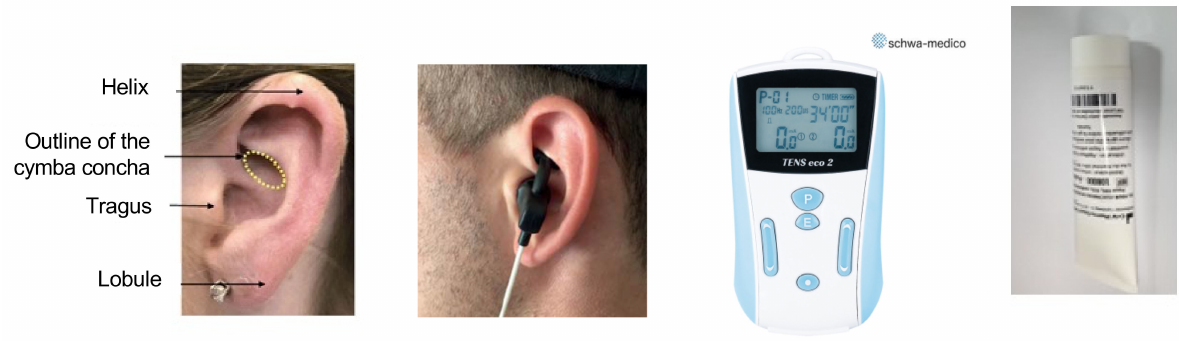
Figure 1. TaVNS device kit. Left to right: Description of the cymba concha, a picture of the auricular electrode applied on the cymba concha, a TENSeco2 device, and the conductive gel (copyright